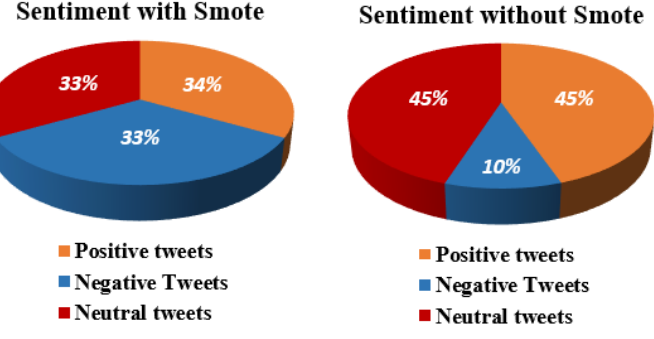
Figure 2. Ratio of sentiment with and without